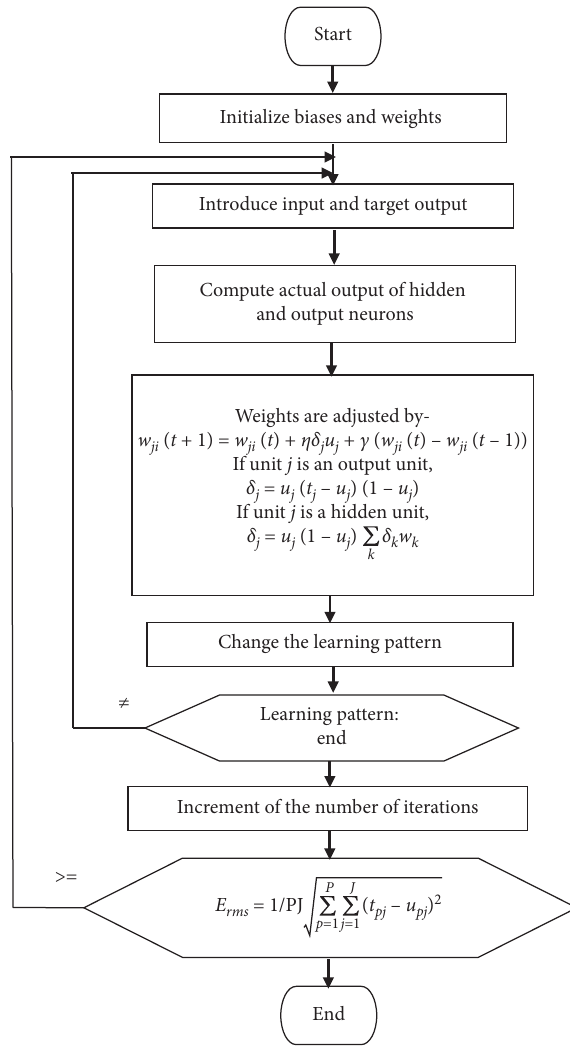
Figure 2: Flowchart of an offline backpropagation training